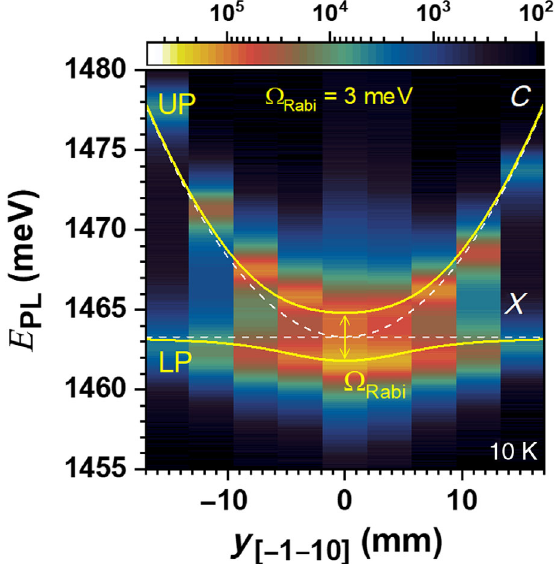
dBm.FIG. 10. Spatial dispersion of photoluminescence of sample B at 10 K. The white dashed lines represent calculated spatial dispersion of bare cavity ( C ) and exciton ( X ) modes. The solid yellow lines are fits using the two coupled oscillators model. The ¼ 3 (cid:2) 0 . 5 fitted Rabi splitting energy is Ω Rabi